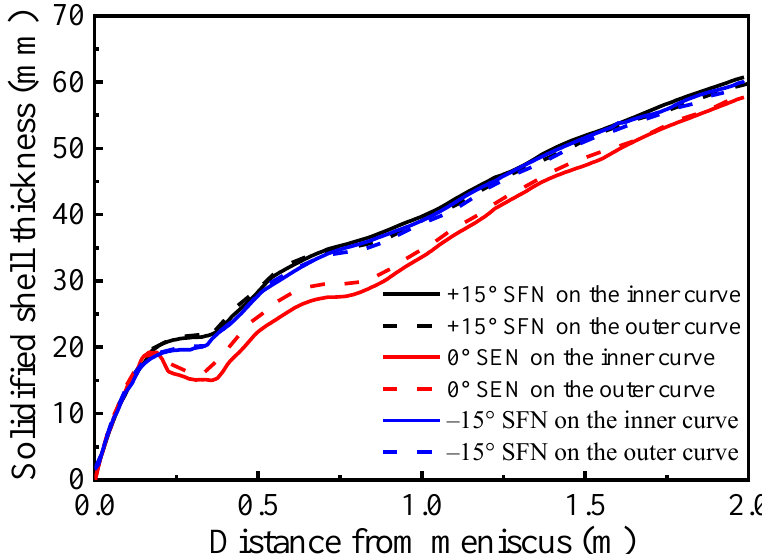
Figure 10. Shell thickness distributions along casting speed direction without M-EMS. The shell thicknesses of 0 ◦ SEN in the inner and outer curves at the mold outlet are 27.48 mm and 29.53 mm, respectively. The thickness of the solidified shell on the inner curved side is smaller than that on the outer curved side, and the difference at the mold outlet is 2.05 mm. The solidified shell thickness on the inner curved side at the mold outlet is less than that on the outer curved side, with a difference of 2.05 mm. This is mainly due to the asymmetry of the flow field between the inner and outer curves of the mold caused by the mold curvature. According to Figure 6, compared with the outer curved side, the solidified shell on the inner curved side of the mold is more severely washed by high-temperature molten steel, the impact depth is larger, and the growth rate of the solidified shell is slower than that of the outer curve. The solidified shell thicknesses of +15 ◦ SFN in the inner and outer curves at the mold outlet are 34.48 mm and 34.47 mm, respectively. The solidified shell thickness in the inner and outer curves at the mold outlet are 33.77 mm and 33.75 mm, respectively. The solidified shell thickness distribution of ± 15 ◦ SFN on the inner and outer curves is basically the same. The horizontal swirl produced by the molten steel through the swirl nozzle significantly weakens the washing of the high-temperature molten steel on the initial shell and eliminates the uneven growth of the solidified shell caused by the mold curvature. SFN is beneficial to the stable growth of solidified shells in the mold and improves mold cooling